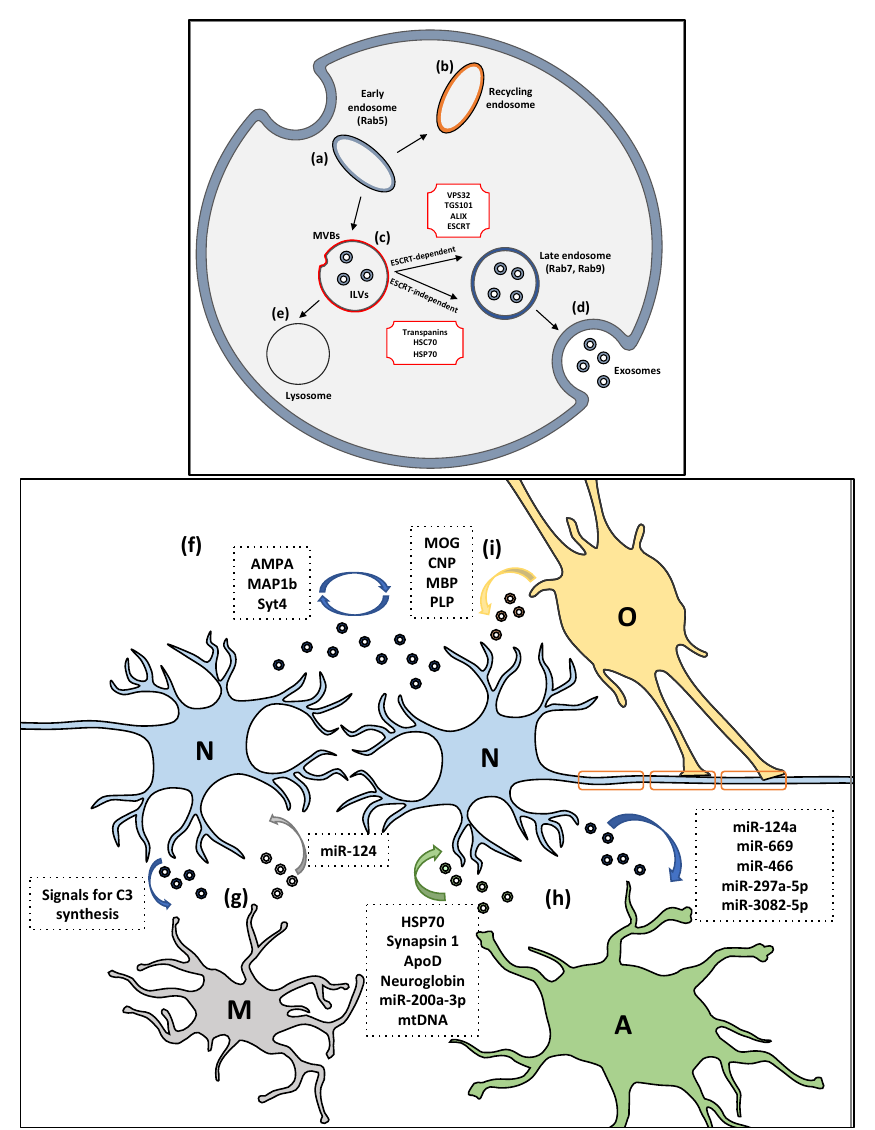
Figure 1. Biogenesis and physiological function of exosomes in neuron-glial communication. ( Up ) ( a ) Endocytic vesicles generate from plasma membrane and are then fused with early endosomes via a Rab5-dependent mechanism. Early endosomes are either sorted for recycling ( b ) or they mature to multivesicular bodies (MVBs) that contain intralumenal vesicles (ILVs) ( c , d ) The formation of late endosomes (characterized by the presence of Rab7 and Rab9 GTPases) is regulated by either ESCTR-dependent or ESCRT-independent mechanisms, that finally lead to exosomal release upon the fusion of MVBs with the plasma membrane. ( e ) Alternatively, MVBs fuse with the lysosome, resulting in cargo degradation. ( Bottom ) ( f ) Neuronal-derived exosomes (blue) mediate intraneuronal communication via bearing proteins responsible for neurotransmitter release and synaptic plasticity (AMPA, MAP1b, Syt4). ( g ) Microglia-derived exosomes (gray) transfer various miRNAs (i.e., miR-124) to neurons (N, blue) which promote neuronal survival, whereas neuronal exosomes up-regulate complement factors (C3) in microglia (M, purple), thus modulating synaptic pruning. ( h ) Exosomes secreted from astrocytes (A, green) contain various proteins and RNAs (HSP70, synapsin-1, ApoD, neuroglobin, miR-300a-3p, mtDNA) that protect neurons against cellular stress and death. Exosomes transferred from neurons to astrocytes carry various mRNAs, all of which lead to GLT-1 upregulation, which prevents neuronal excitotoxicity. ( i ) Oligodendrocytes (O, orange) secrete exosomes that are enriched with myelin and stress-protective proteins (MOG, PLP, MBP, CNP) and provide trophic support to neuronal